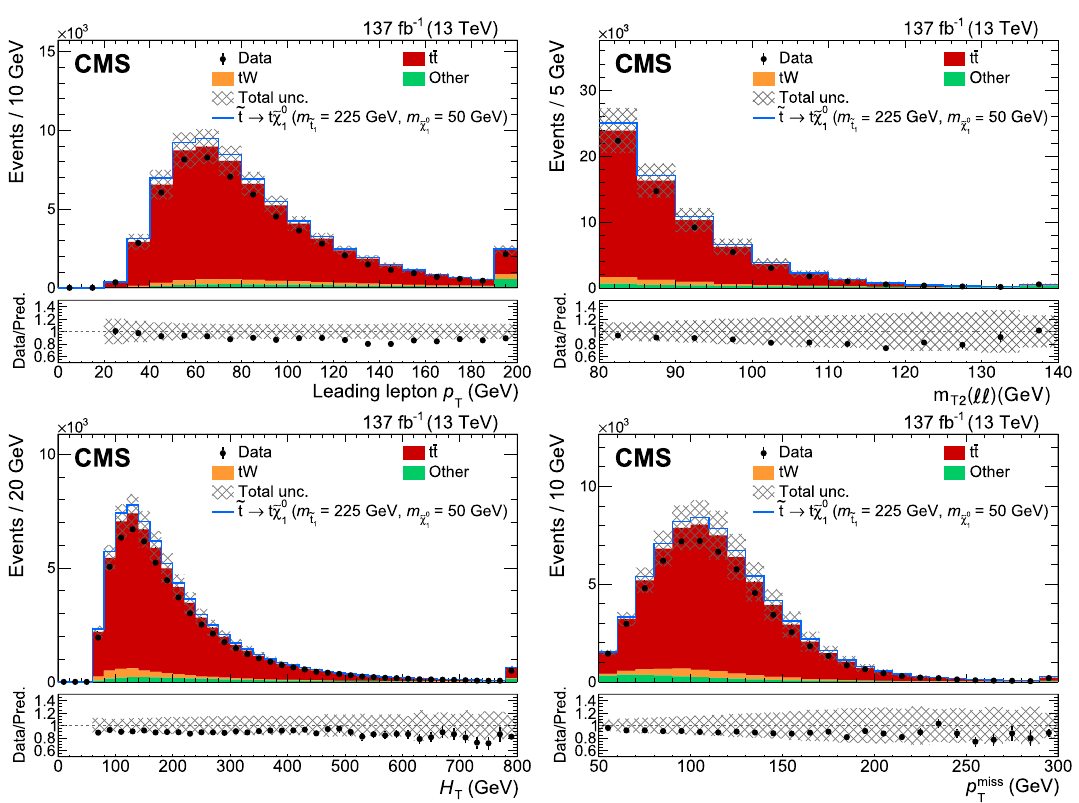
Fig. 3 Pre-fit distributions of data and MC events in the signal region ‘Other’ category. The lower panel contains the data-to-SM prediction with the signal stacked on above the background prediction for a mass ratio. The uncertainty band includes statistical, background normaliza- = 50GeV. Events from ttW, hypothesis of m (cid:2) t1 = 225GeV and m tion and all systematic uncertainties described in Sect. 6.4. From upper (cid:2) χ 0 1 left to lower right: leading lepton p T , m T2 ((cid:4)(cid:4)) , H T , and p miss ttZ, DY, nonprompt leptons, and diboson processes are grouped into the